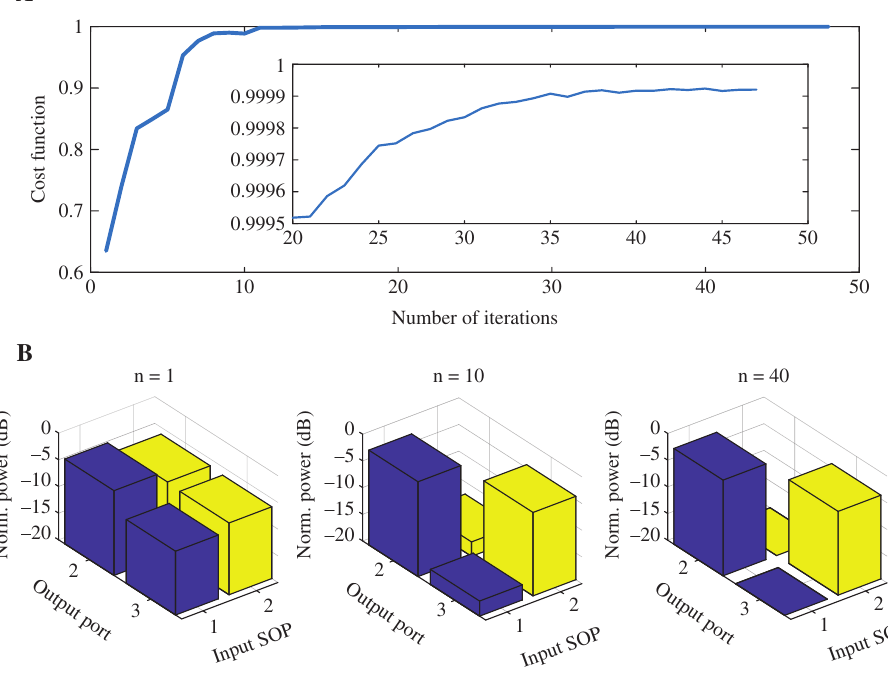
Figure 3: Training process for polarization MIMO descrambler. (A) Cost function dependent on the number of iterations (Video S1). (B) Light power distributions when the number of iterations equals 1, 10, and 40.